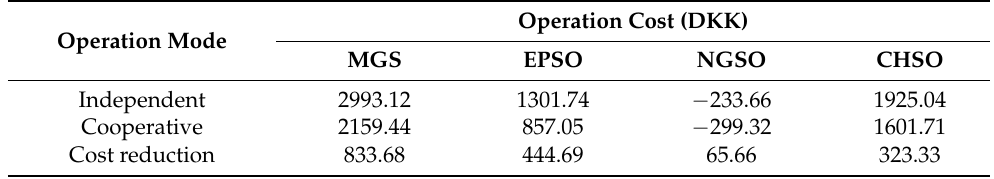
Table 3. Operating costs of Case 1 and Case